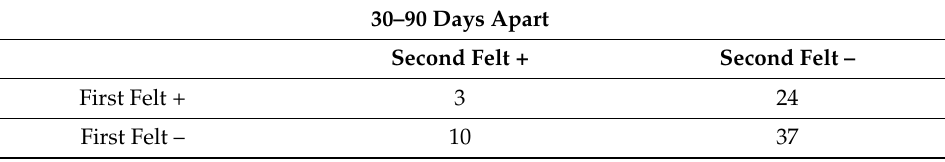
Table A4. Contingency tables for egg presence (+) or absence (–) at co-located basement traps sampled 30–90 days